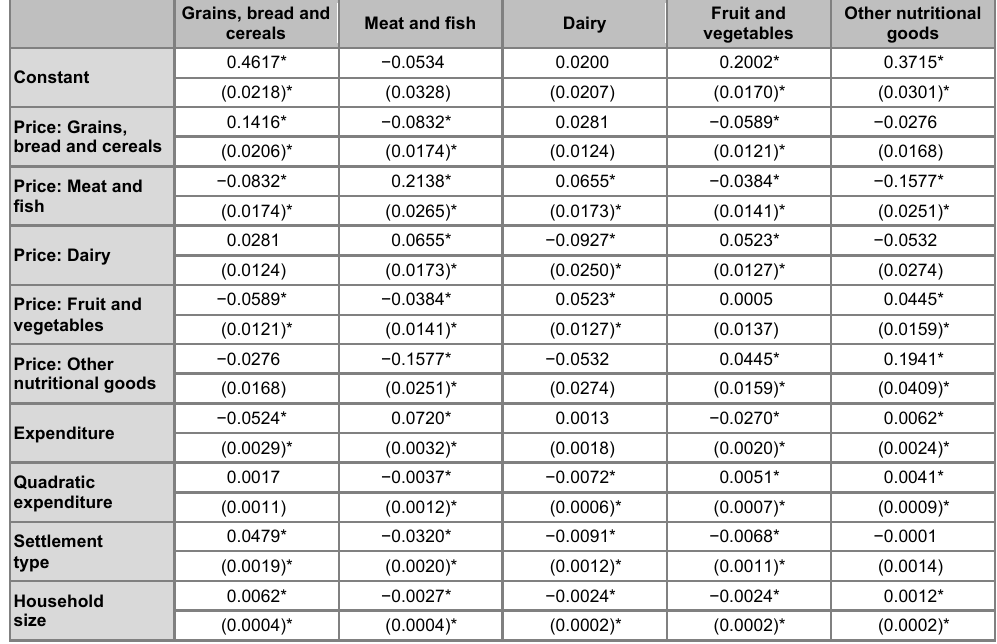
Nutritional goods demand system coefficients estimated with QUAIDS Grains, bread and Meat and fish Dairy cereals